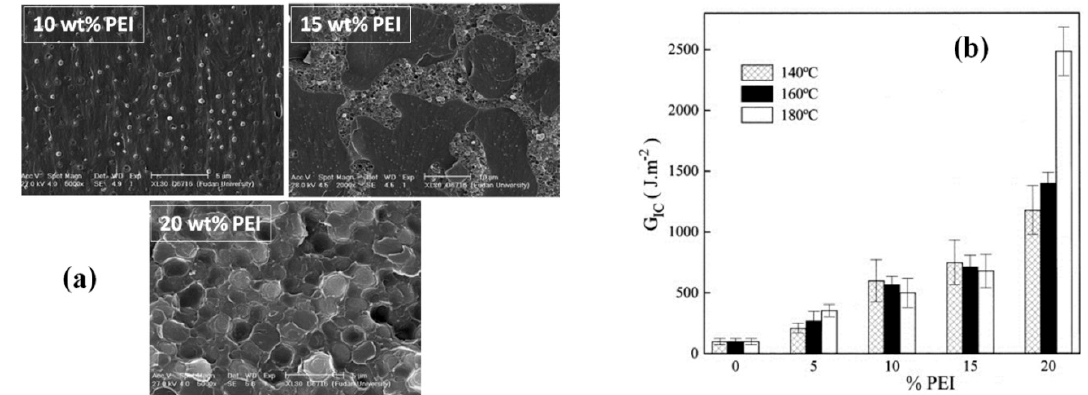
Figure 10. ( a ) Phase morphologies as a function of PEI content in epoxy / PEI system (particulate morphology at 10 wt % PEI, co-continuous morphology at 15 wt % PEI and phase-inverted morphology at 20 wt % PEI). Reprinted with permission from ref. [28], Copyright [2018], American Chemical Society. ( b ) Fracture energy of epoxy / PEI systems as a function of PEI content at di ff erent curing temperatures. Reprinted with permission from ref. [33], Copyright [2001], John Wiley and